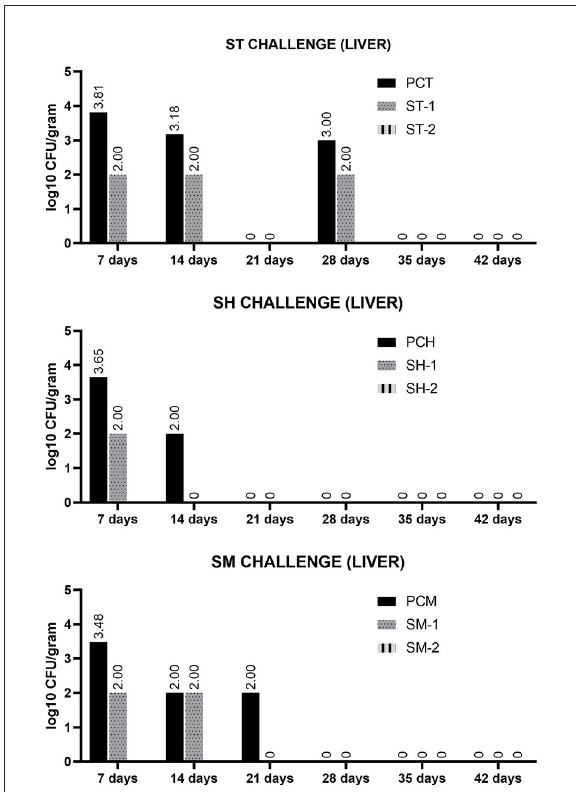
FIGURE2 Bacterial numbers of SH, ST and SM in pools of 5 liver samples, after challenge of 3 days-old and 33 days-old broilers in groups SH-1, ST-1 and SM-1 (treated from 1 to 21 days-of-age and from 35 to 42 days-of-age), SH-2, ST-2 and SM-2 (treated from 35 to 42 days-of-age) and positive control groups PCH, PCT and PCM (untreated), at respective days-of-age. Considering this data were obtained from single pools for each moment, no statistics were performed for this